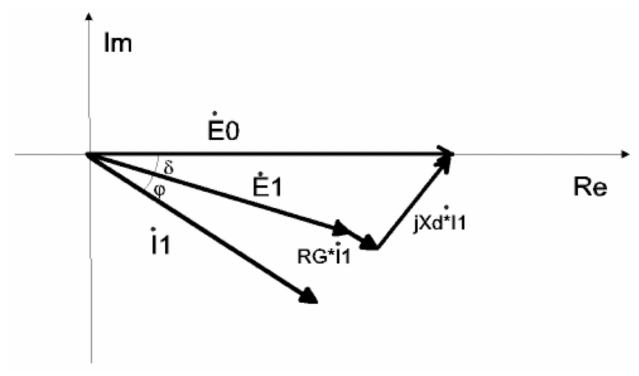
Figure 8. HSG generators phasors.